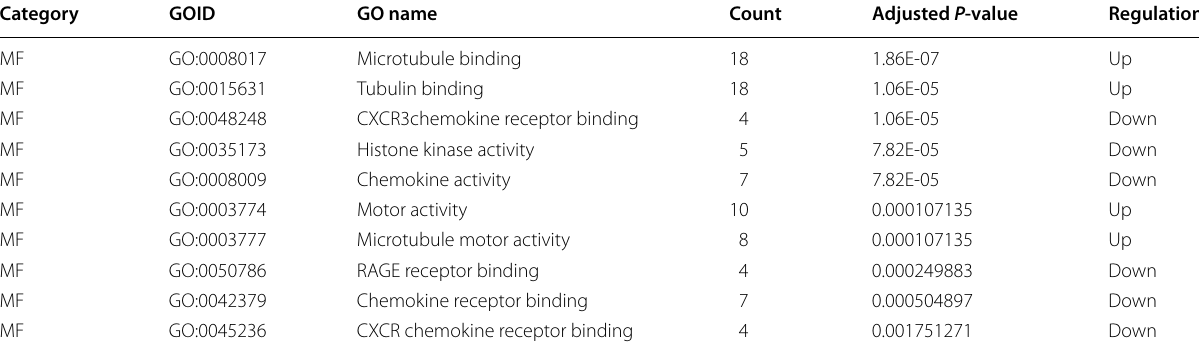
Table 3 The top enriched molecular function of DEGs in the daily alcohol user group sorted by adjusted P-values in a descending